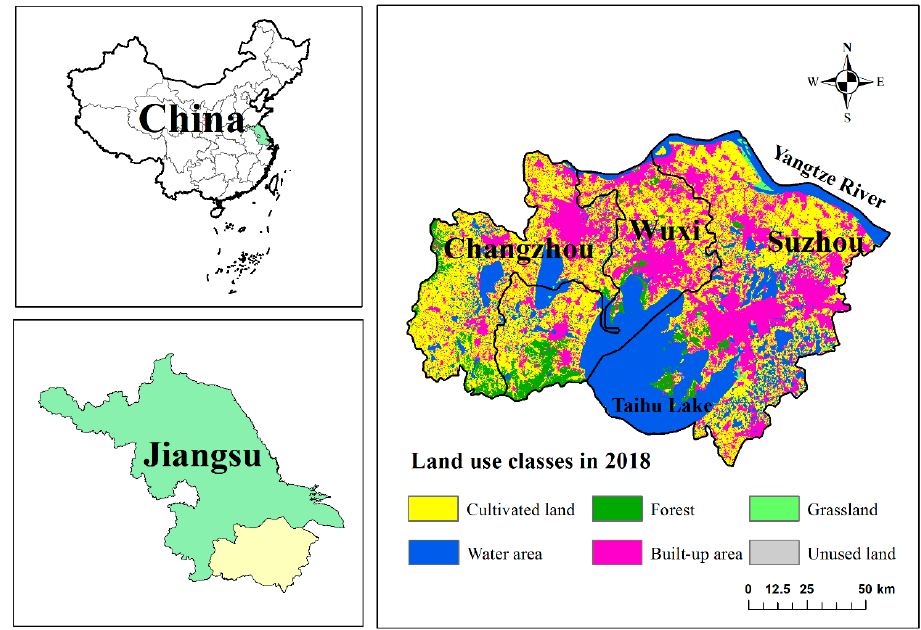
Figure 1. Location of the Su-Xi-Chang region.